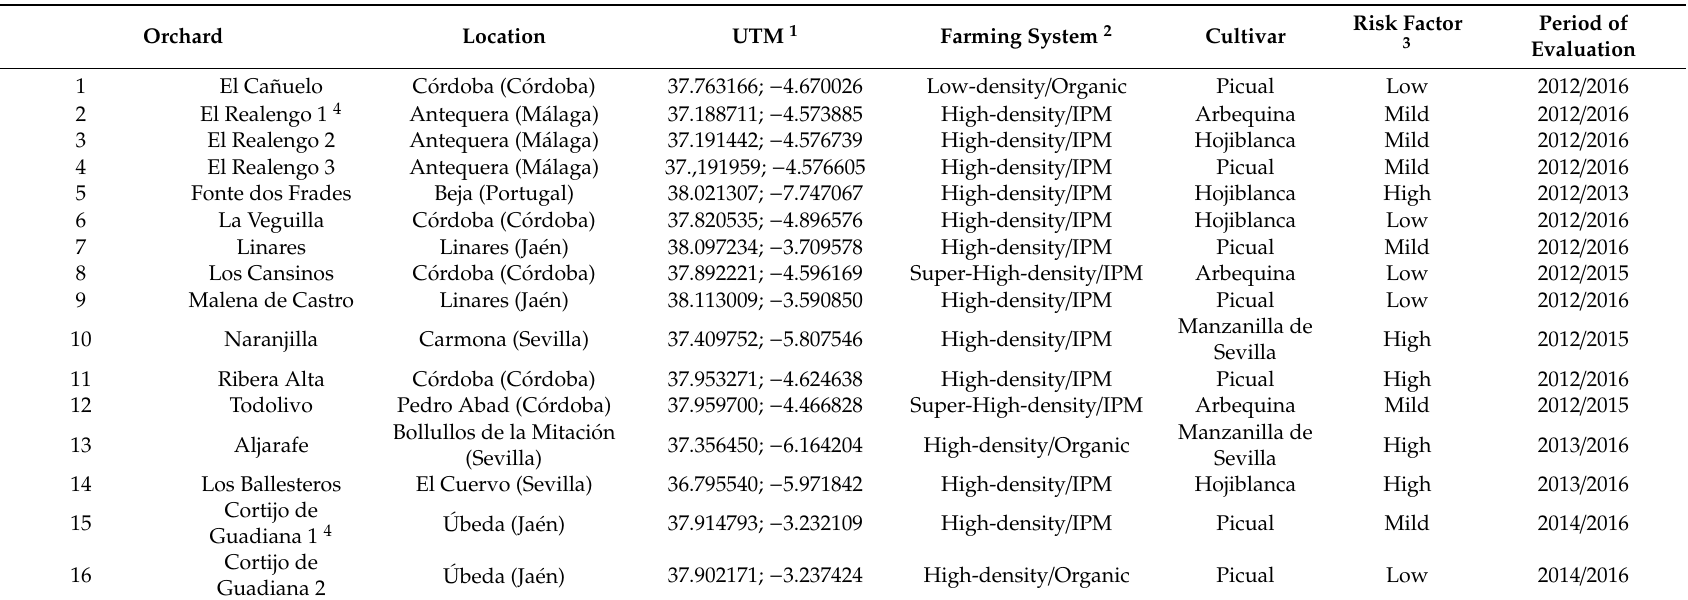
Table 2. Olive orchards selected to compare management